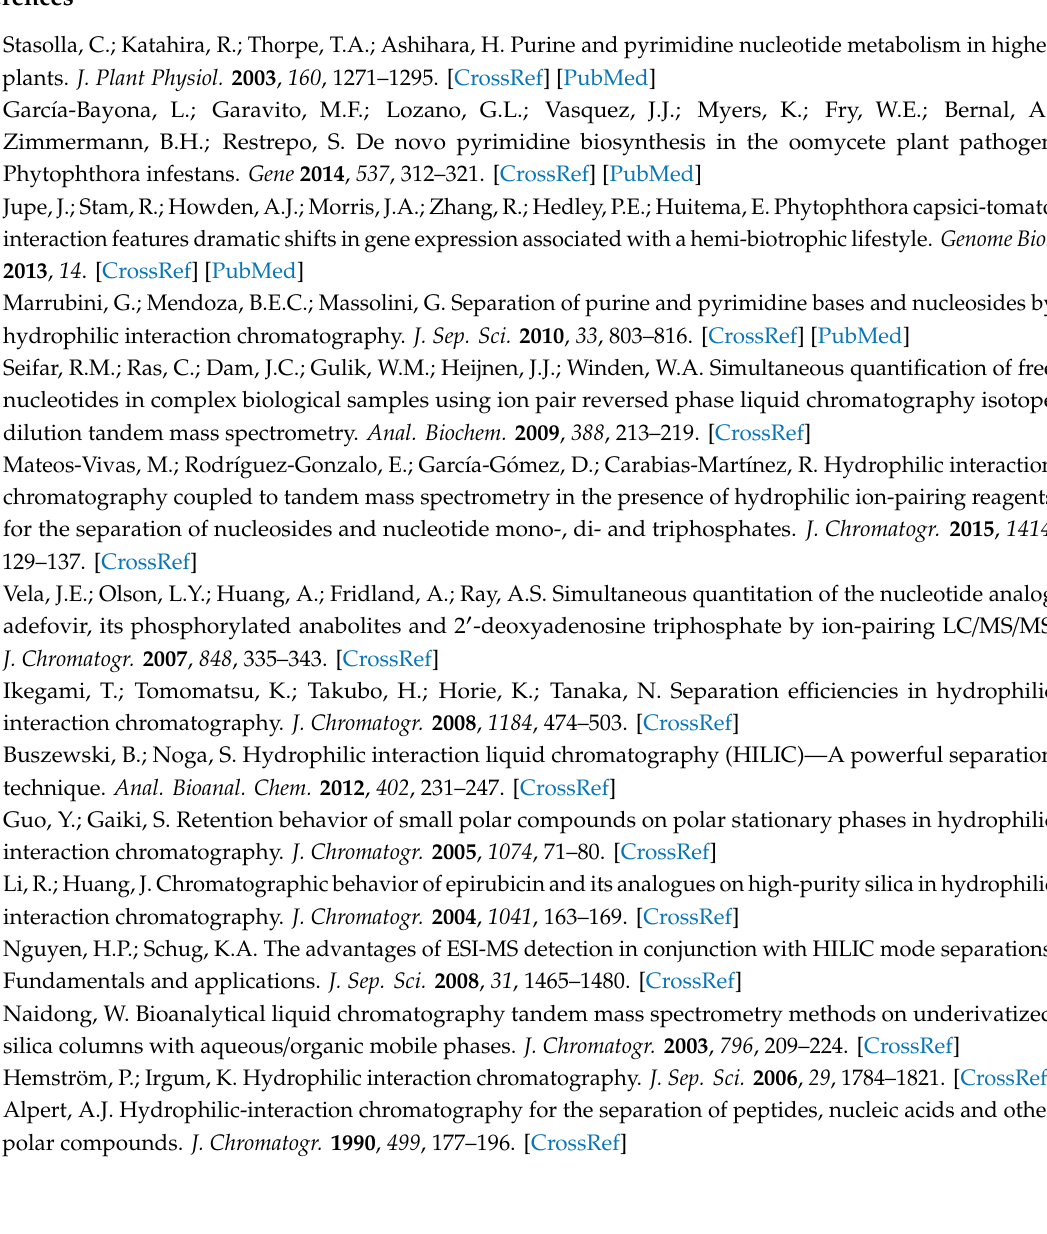
Table S1: List of dn SP compounds; Table S2: E ff ects and significance of the variables evaluated on the response variables; Table S3: Optimal factor values of ZIC-p-HILIC and ZIC-HILIC columns; Table S4: Linearity, correlation coe ffi cient (r 2 ), LOD and LOQ for ZIC-p-HILIC; Figure S1: Chromatographic parameters; Figure S2: Pareto´s charts of standardized e ff ects: (a) E ffi ciency (N); (b) Retention factor ( k ); (c) Resolution (R) and (d) Peak height (h); Figure S3: Extracted ionic current (EIC). ZIC-p-HILIC; Figure S4: ZIC-p-HILIC LC-MS chromatogram for some of de novo pyrimidine pathway analytes in tomato infected leave